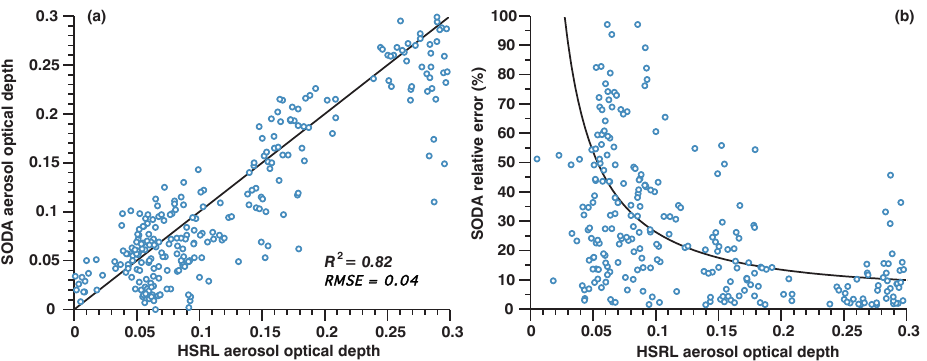
Figure 7. (a) A scatter plot of SODA AOD relative to AOD measured by HSRL at 532nm with corresponding R 2 and RMSE. The black line illustrates the 1:1 line. (b) Relative uncertainty in the SODA column lidar ratio as a function of HSRL AOD with the black line showing the least squares exponential fit as in Josset et al. (2012), Eq. (15). All points are classified as marine plus pollution or marine plus dust and are from Table 1 in Josset et al. (2011).